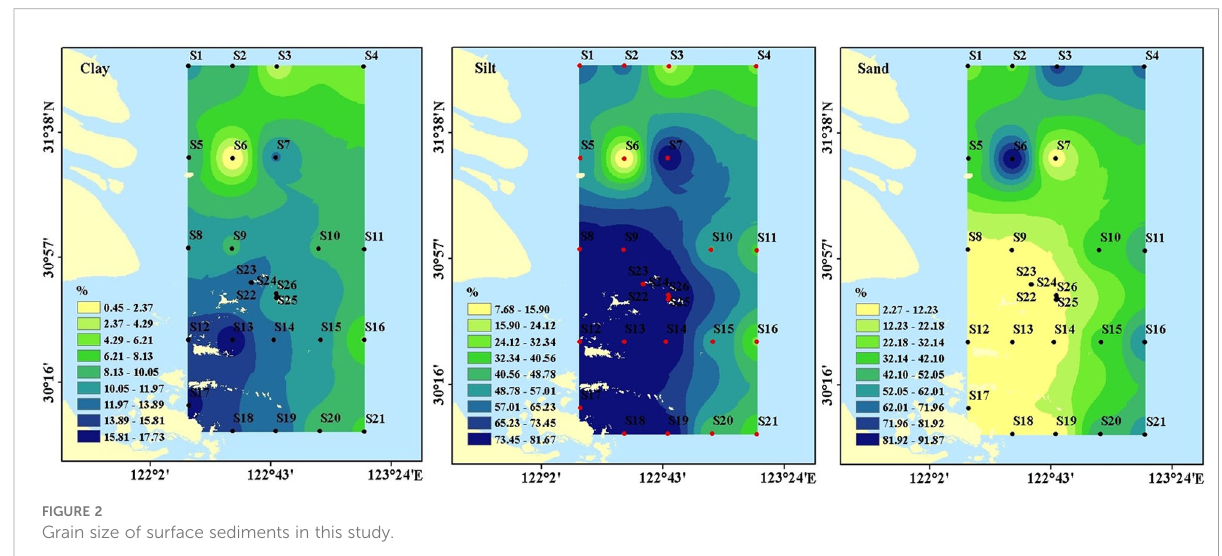
FIGURE 2 Grain size of surface sediments in this